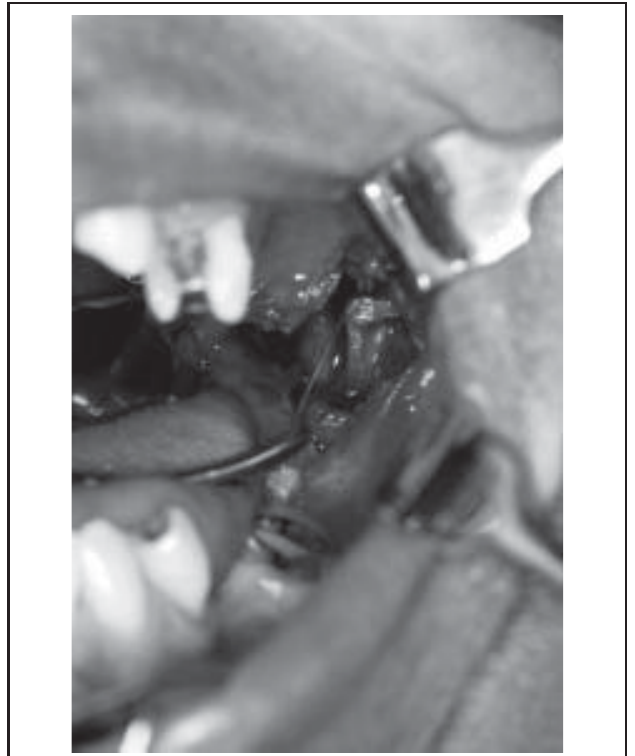
Figure 2. Retrieval of the broken needle.